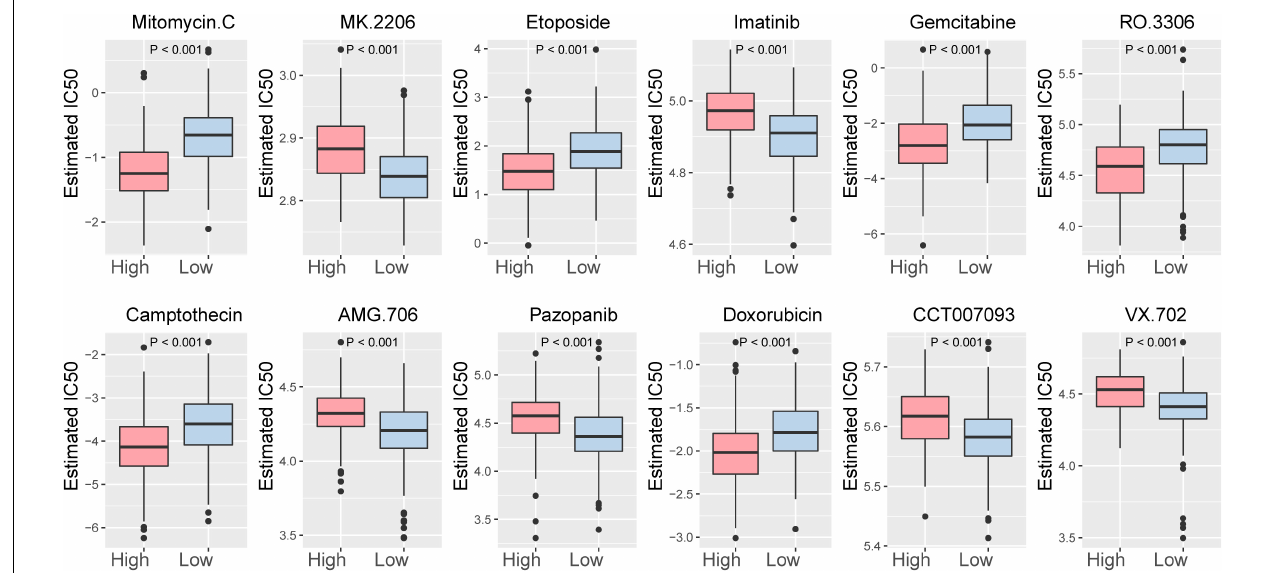
FIGURE 8 | The first 12 drugs with different responses between the high ICI score subgroup and low ICI score